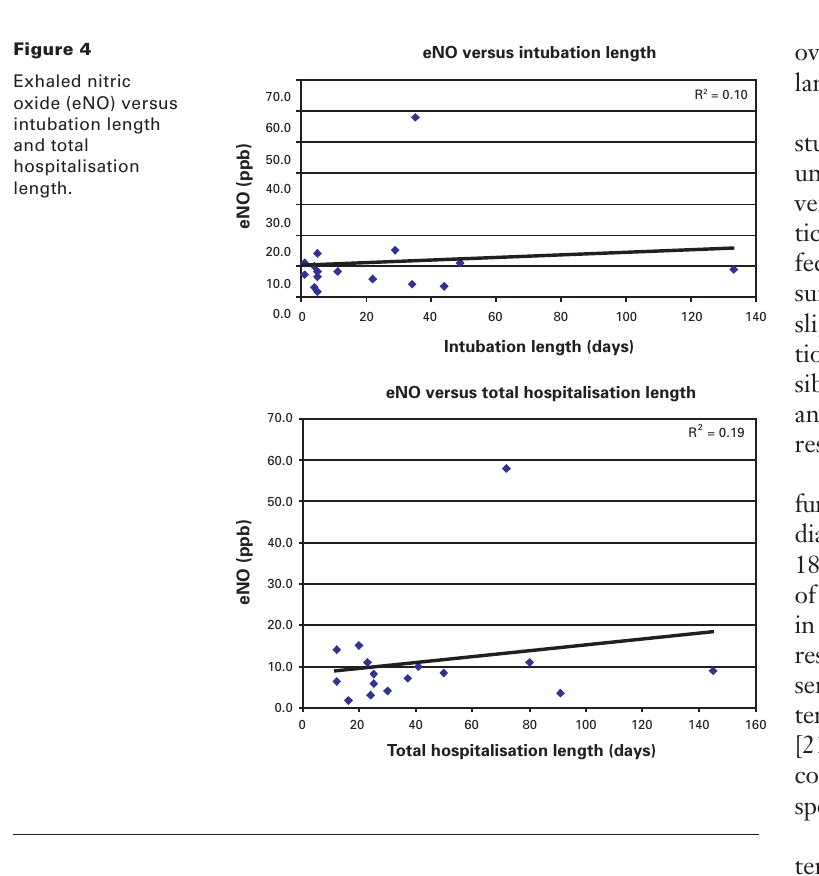
Figure 5 Resistance at 8 Hz (R8) versus intuba- tion length, ICU hospitalisation length and total hos- pitalisation